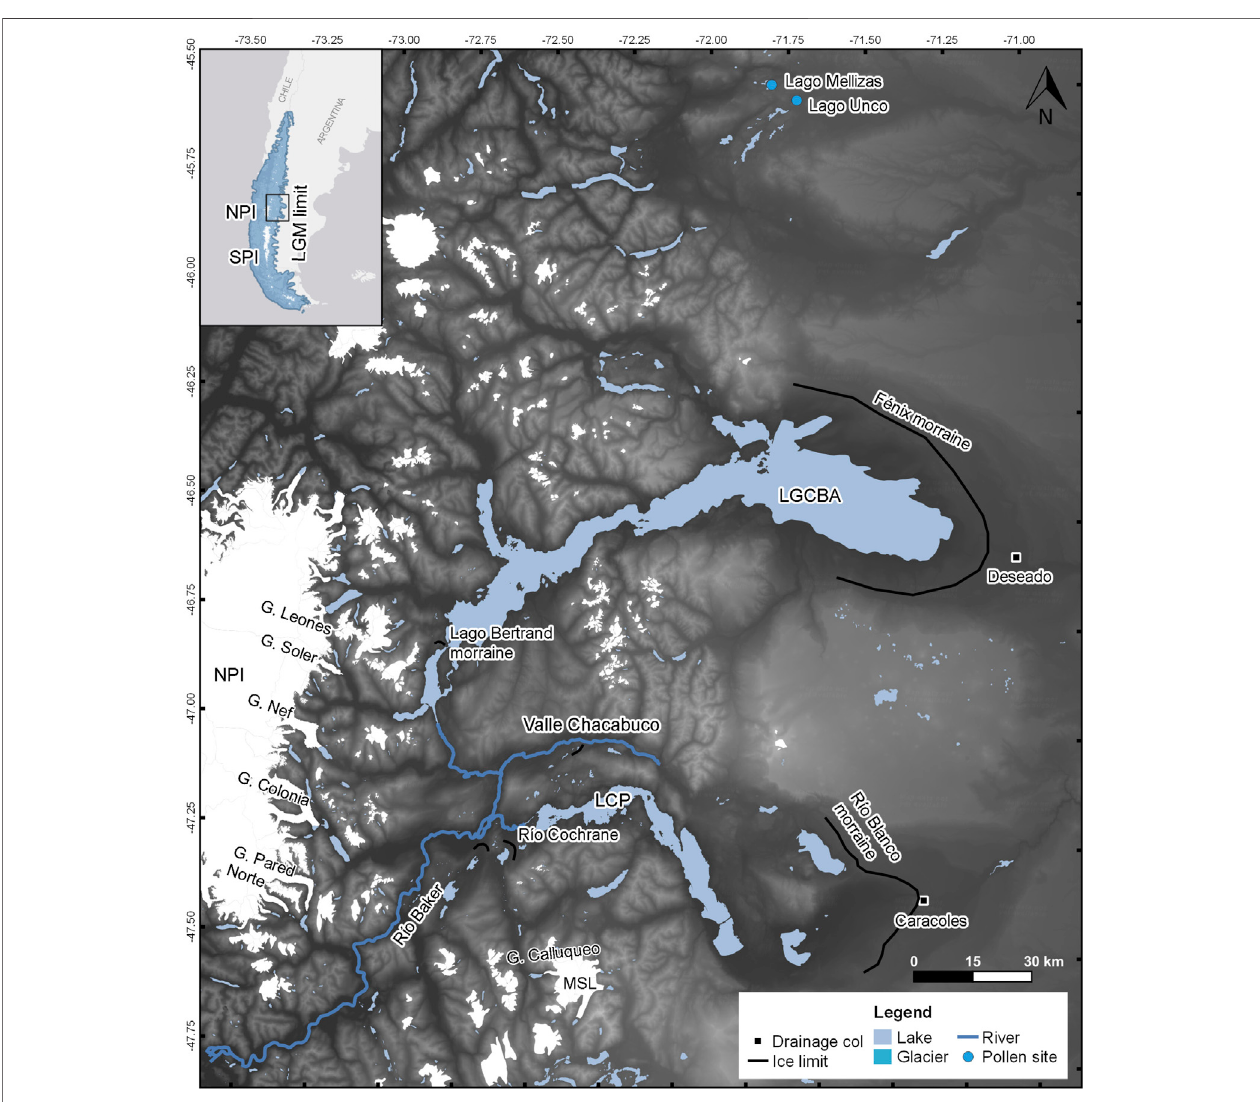
FIGURE 1 | Overview of the study region. Lake, river, glacier, and LGM limit shapes were obtained from Davies et al. (2020) for reference only. NPI, North PatagonianIce fi eld; SPI,South Patagonian Ice fi eld;MSL,Monte SanLorenzoIce Cap.LCP, LagoCochrane/Pueyrredon;LGCBA, LagoGeneralCarrera/BuenosAires.